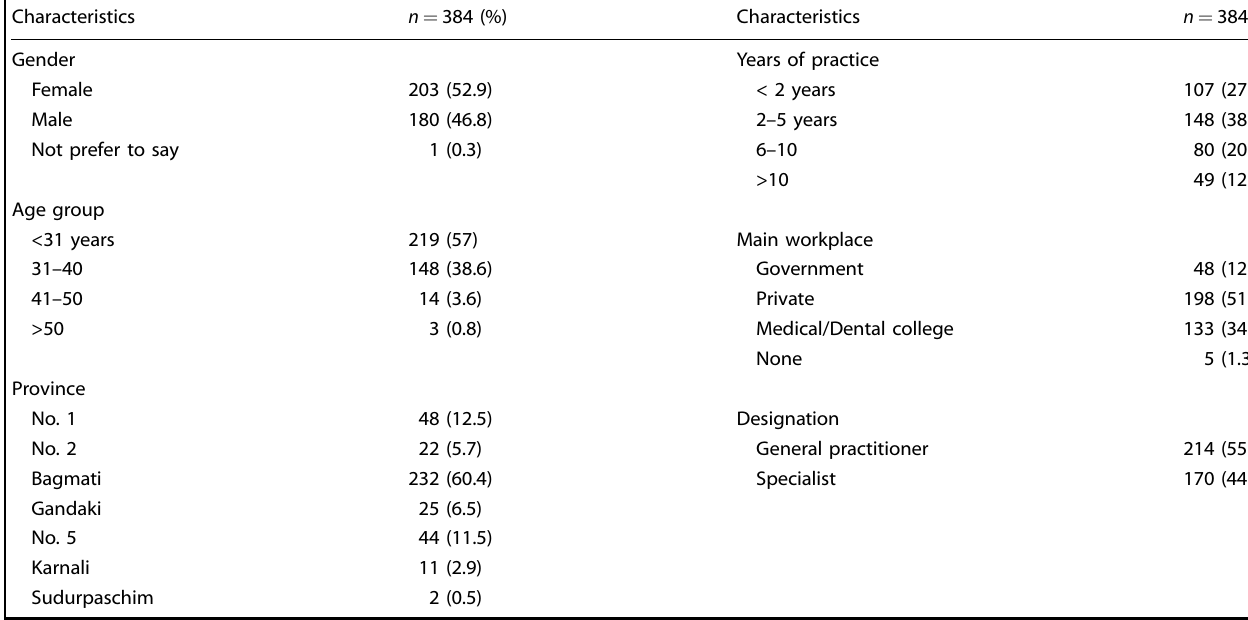
Table 1. Distribution of Nepalese dentists according to their various characteristics. Characteristics